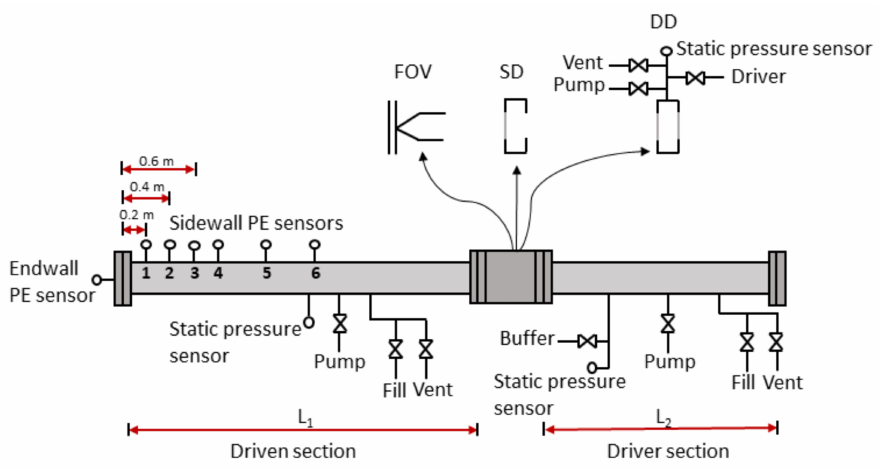
Figure 1. Schematic illustration of the shock tube. FOV, fast-opening valve; SD, single diaphragm; DD, double